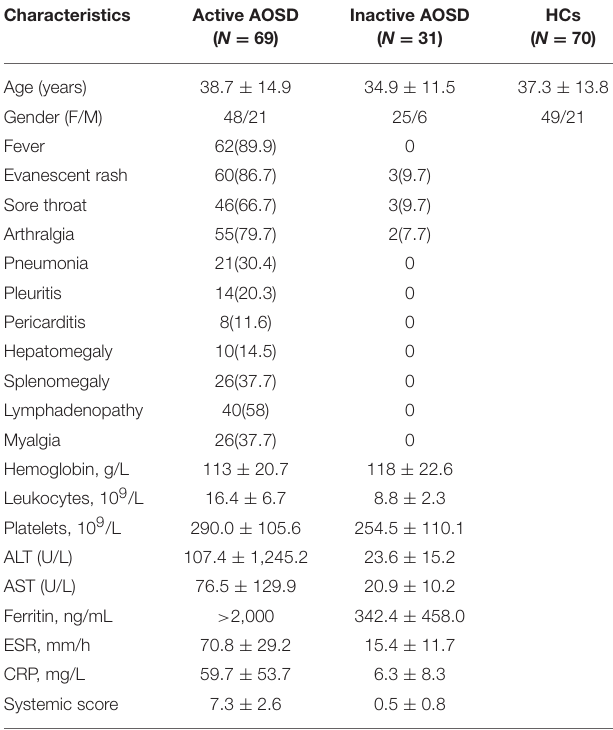
TABLE 1 | Demographic and clinical characteristics of individuals with